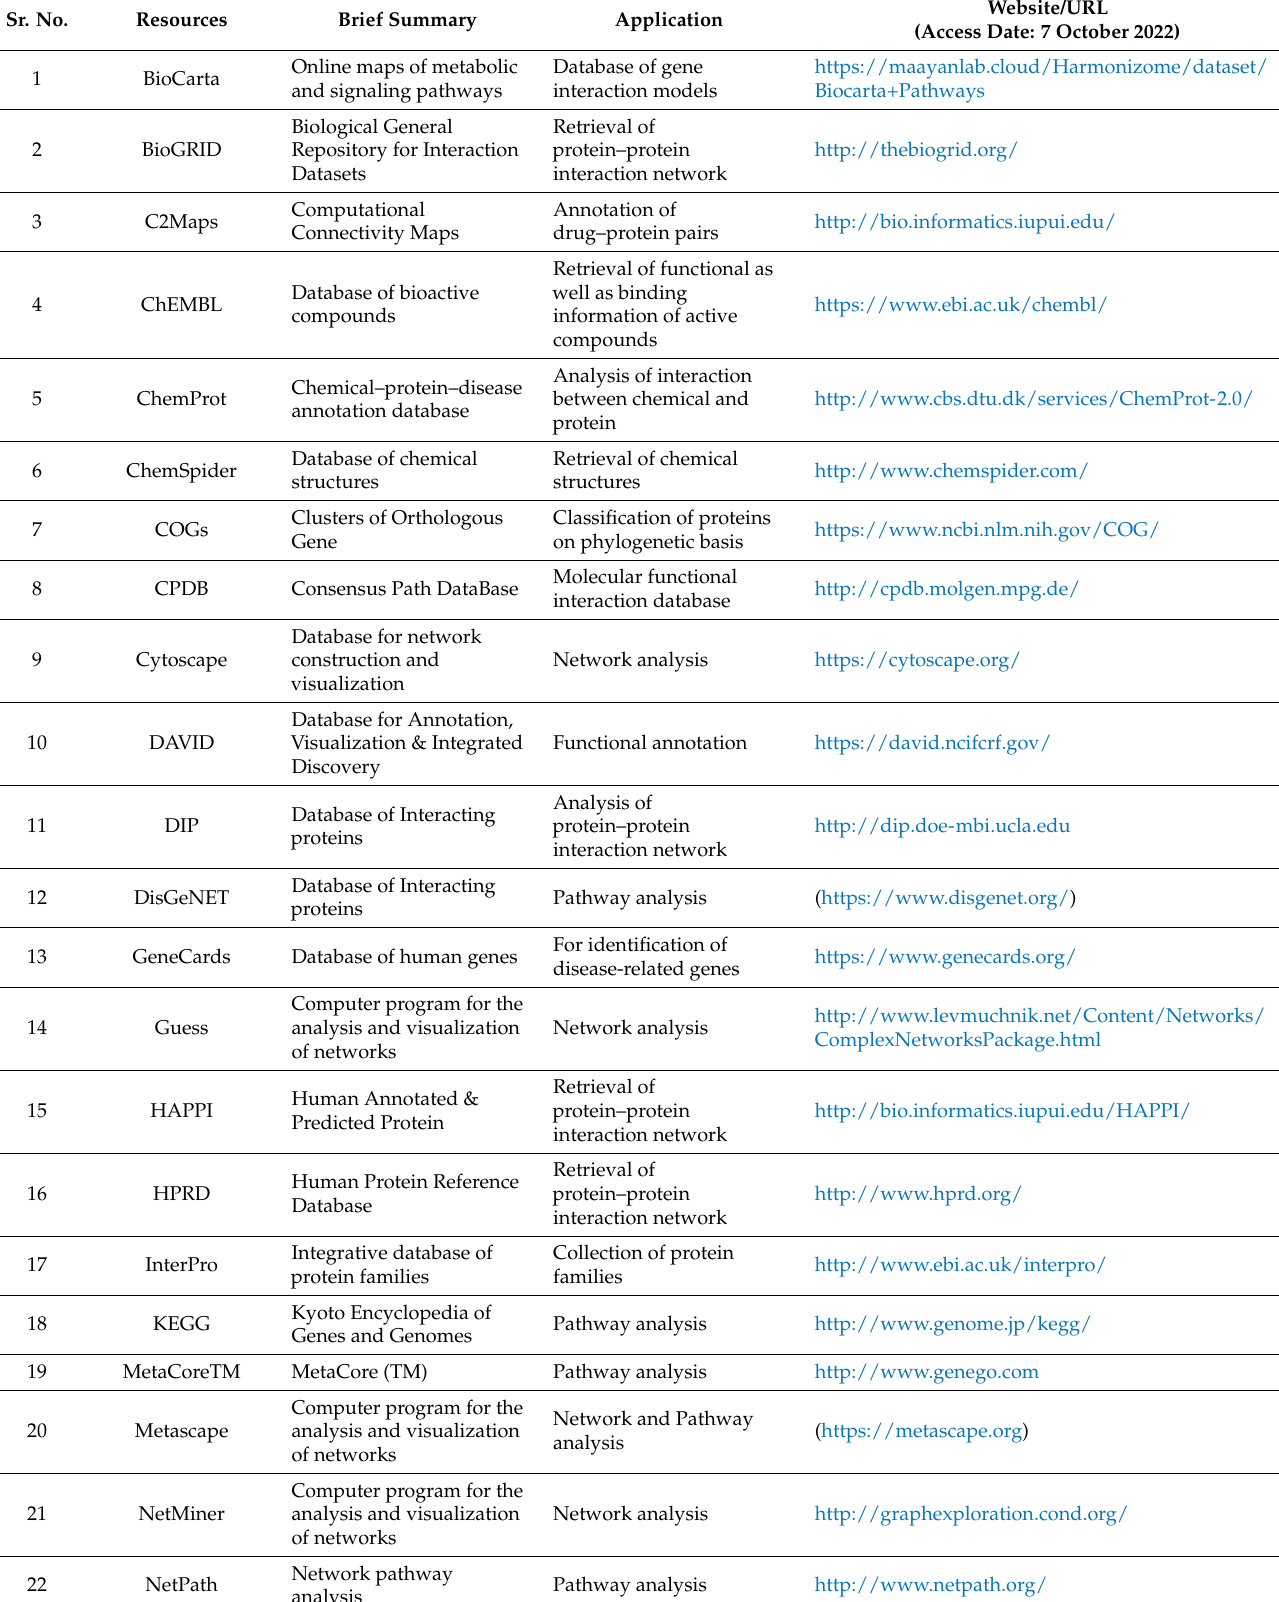
Table 2. Online resources for network biology, network pharmacology, and gene enrichment analysis. Sr.